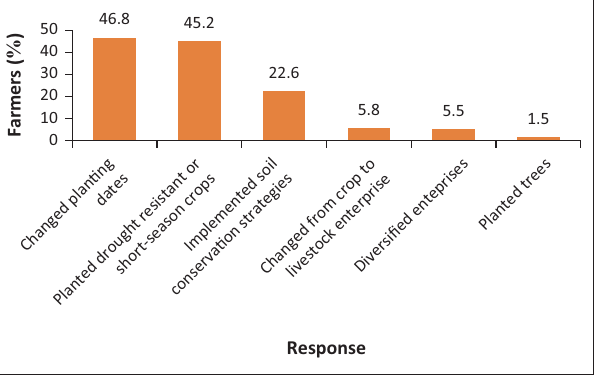
FIGURE 4: Smallholder farmers’ response to climate